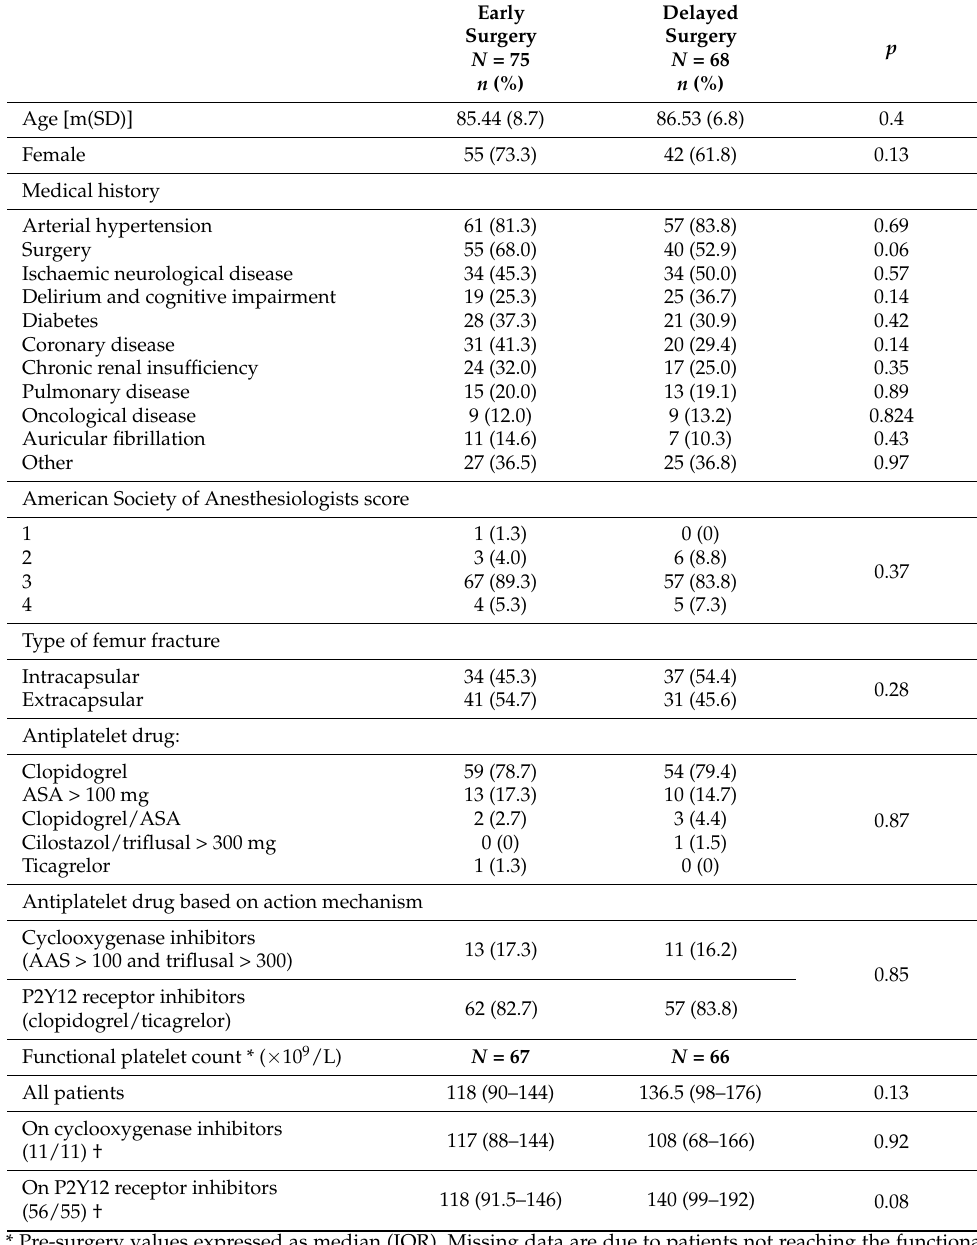
Table 1. Per-protocol baseline characteristics of patients by study